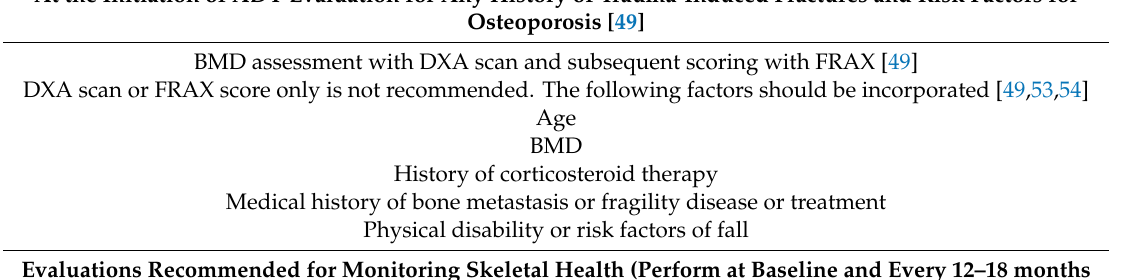
Table 2. Summary of clinical guidelines for the assessment and monitoring of adverse skeletal events. At the Initiation of ADT Evaluation for Any History of Trauma-Induced Fractures and Risk Factors for Osteoporosis